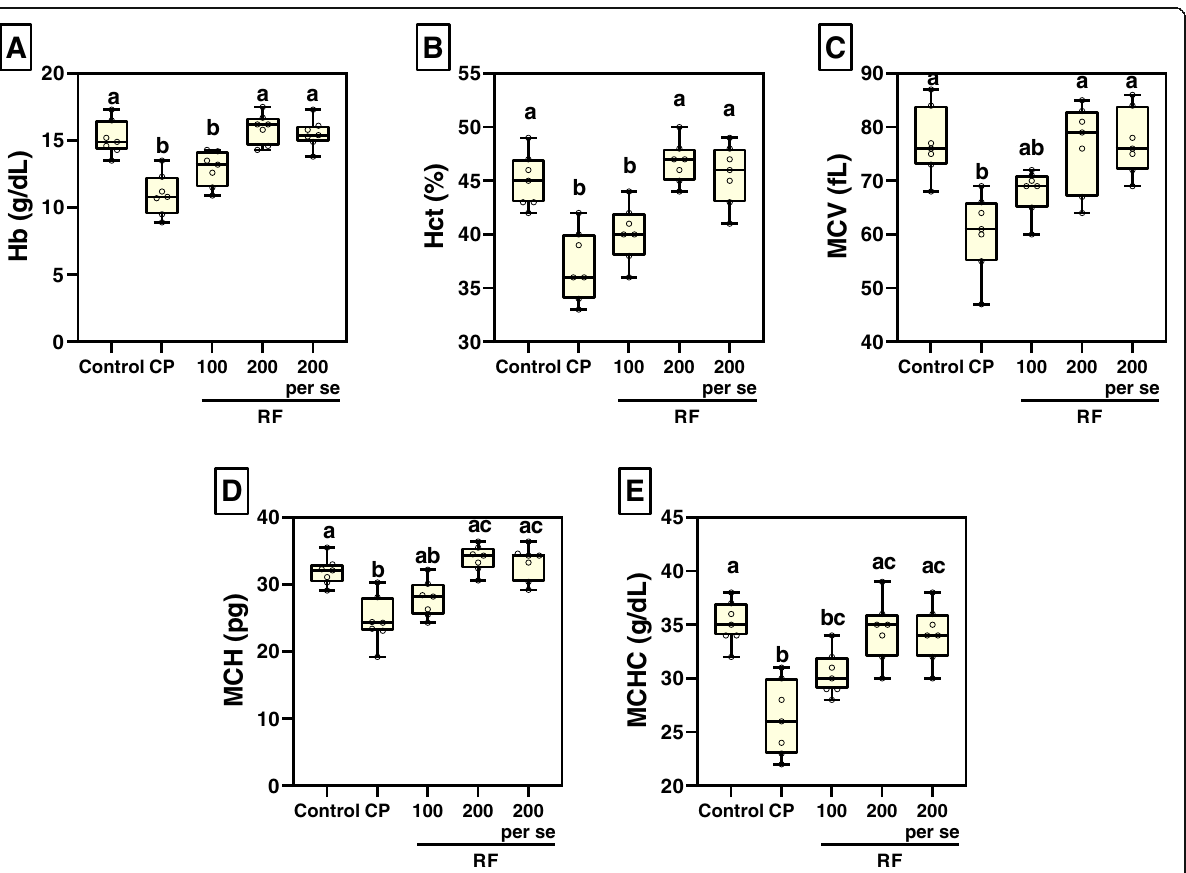
Fig. 2 The effect of RF on blood Hb ( a ), Hct ( b ), MCV ( c ), MCH ( d ), and MCHC ( e ). Results are expressed as group median (min, max) and analyzed by ANOVA or Kruskal – Wallis, followed by the Tukey or Dunn posttests, respectively (n = 7). Different small letters in the box indicate the